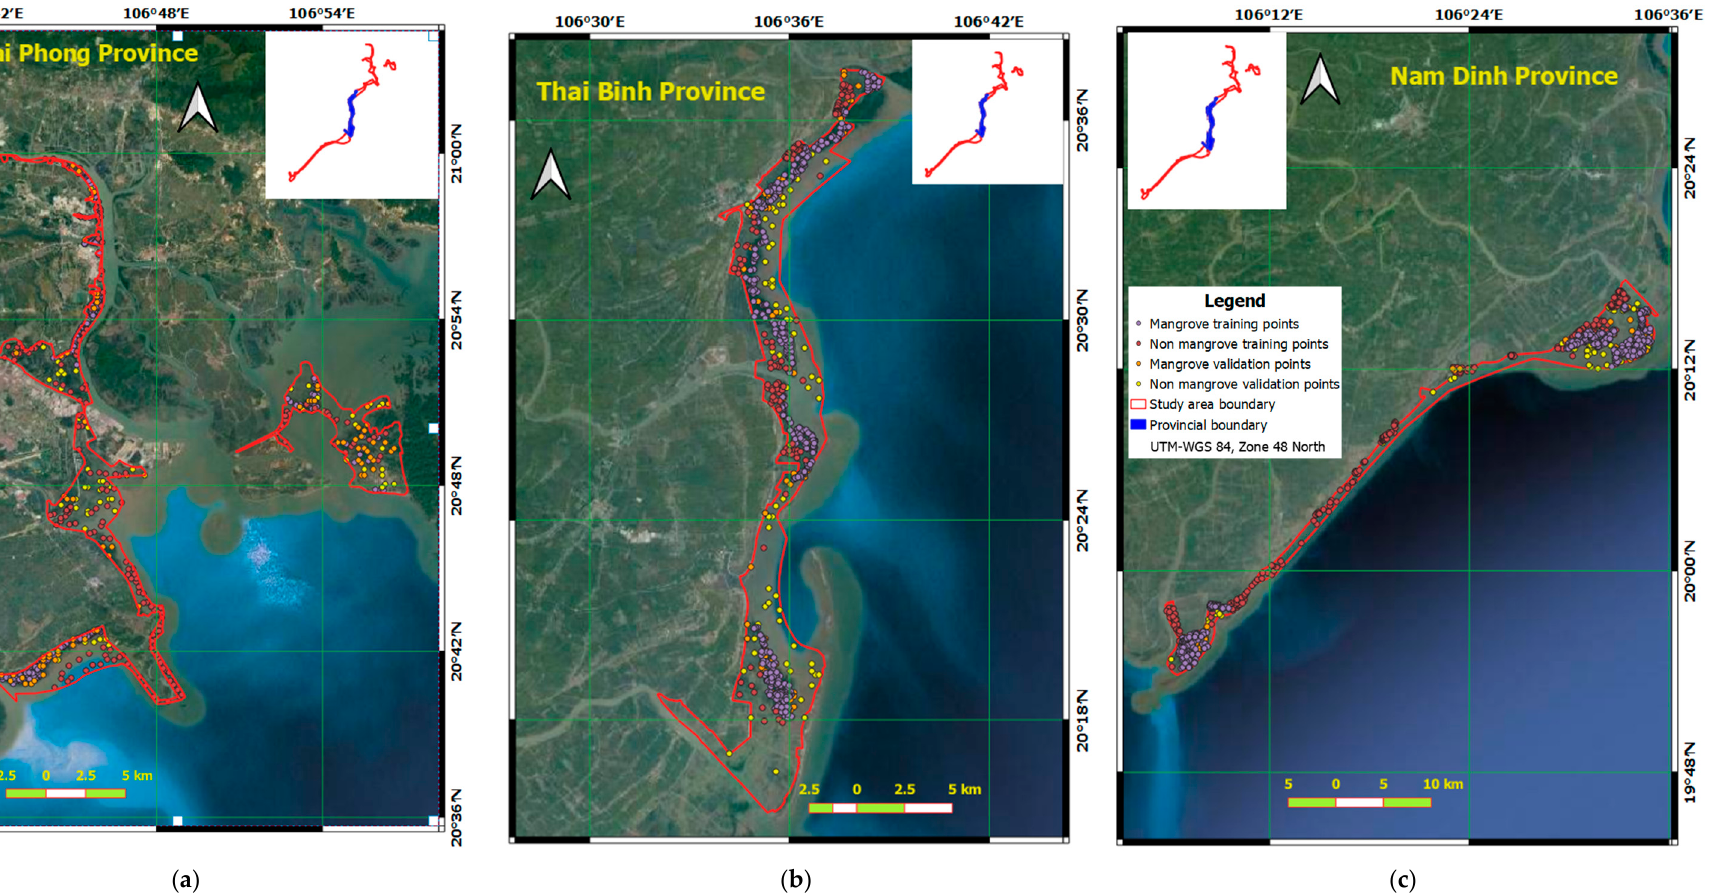
Figure 2. Training and validation points for mangrove mapping during the year 2020 in the RRD, Vietnam: ( a ) Hai Phong; ( b ) Thai Binh; ( c ) Nam Dinh.